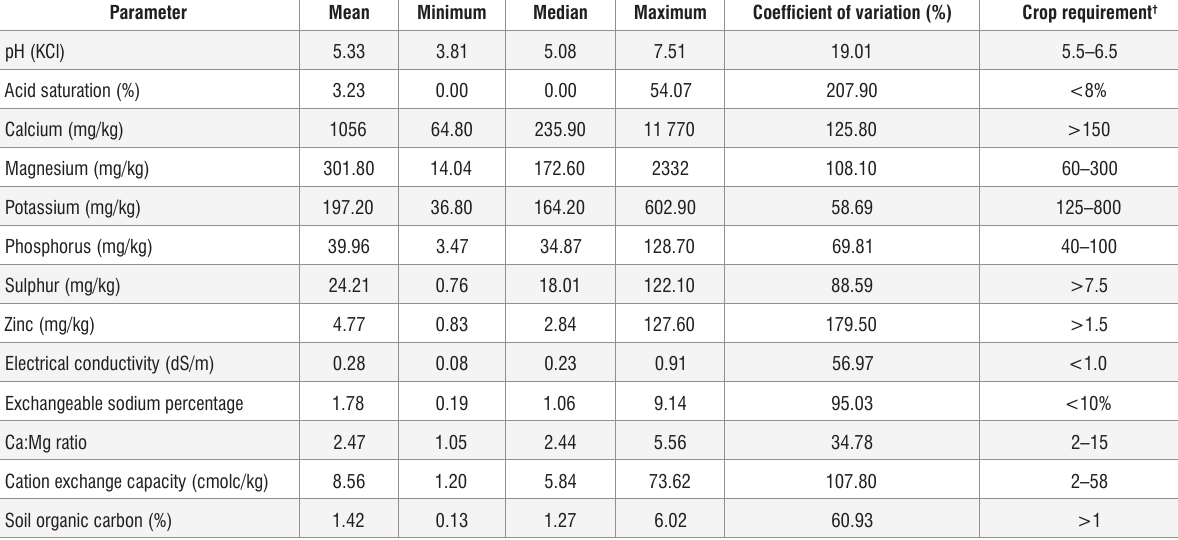
Table 3: Summary statistics for soil fertility parameters on irrigation wheat fields in South Africa